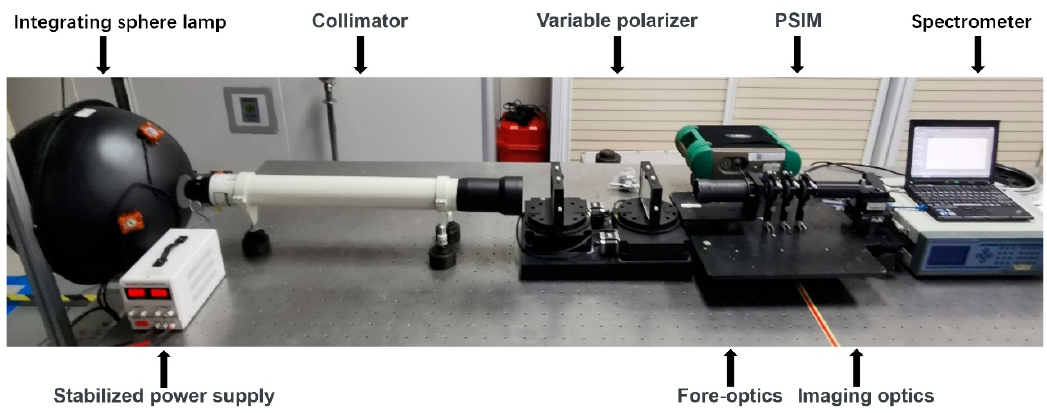
Figure 5. Photograph of the experimental configuration.